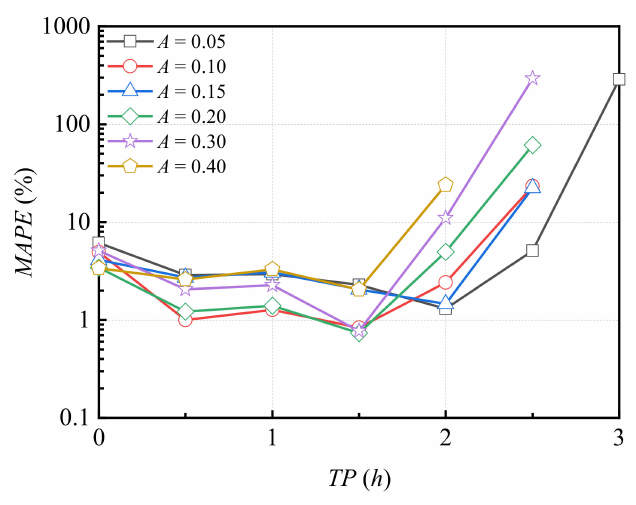
Figure 11. MAPE of working